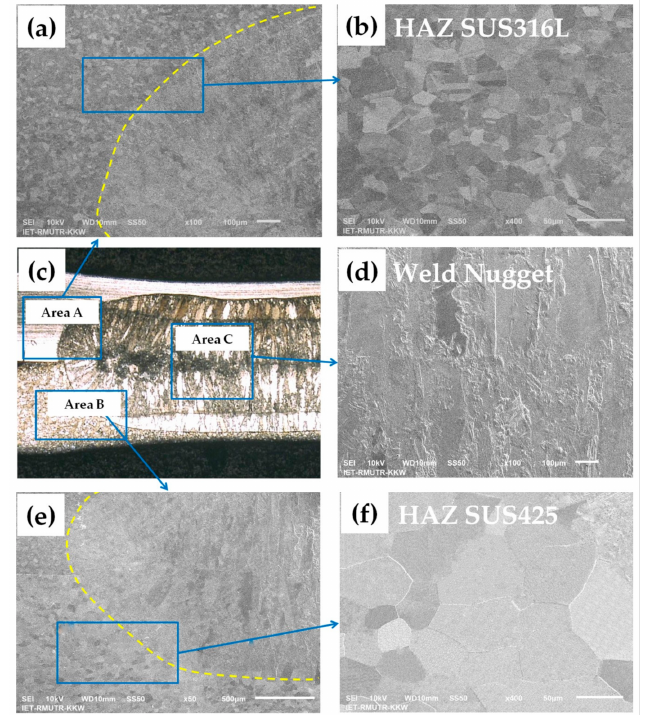
Figure 15. Cross-sectional microstructure of weldment under an 8.5 kA weld current and 25-cycle welding